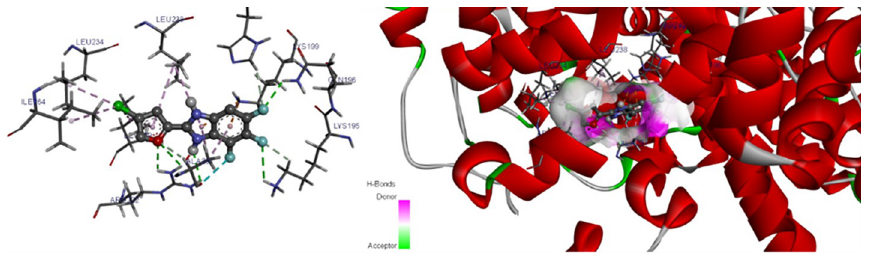
Fig 8. 3D depictions of 5e docking in the active site of human serum albumin